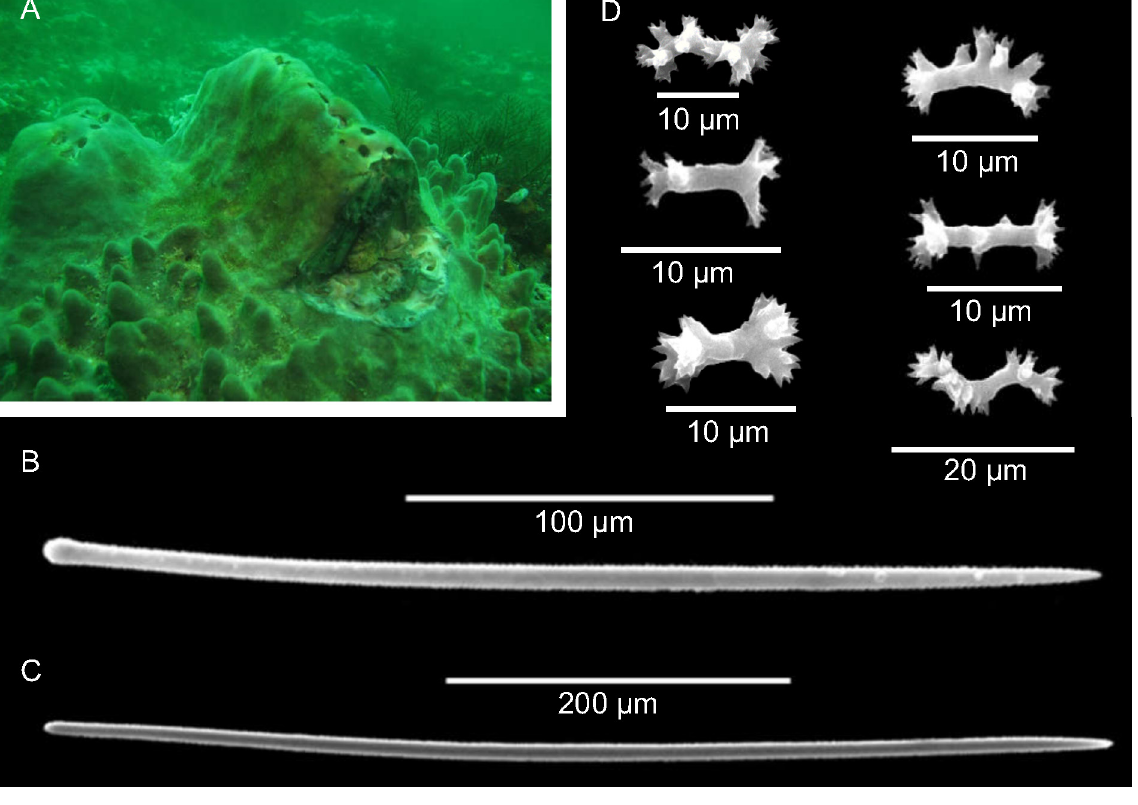
Fig. 17. Spheciospongia vagabunda (Ridley, 1884). A . Specimen PdO14 in situ . B . Big style. C . Small style. D .